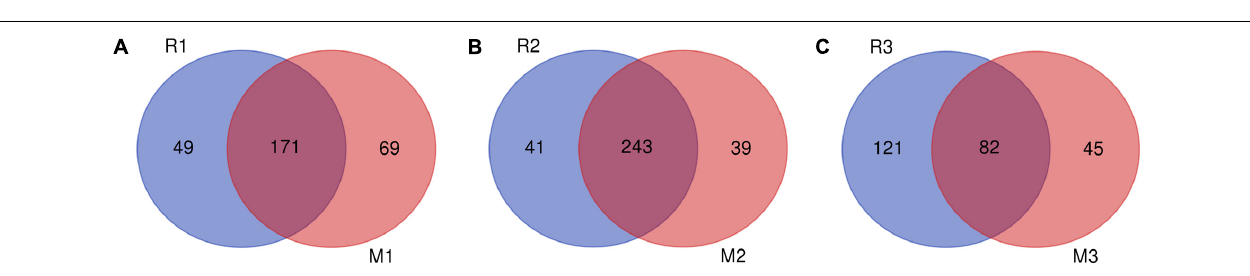
bugs, Adelphocoris suturalis Jakovlev (Luo et al., 2021).